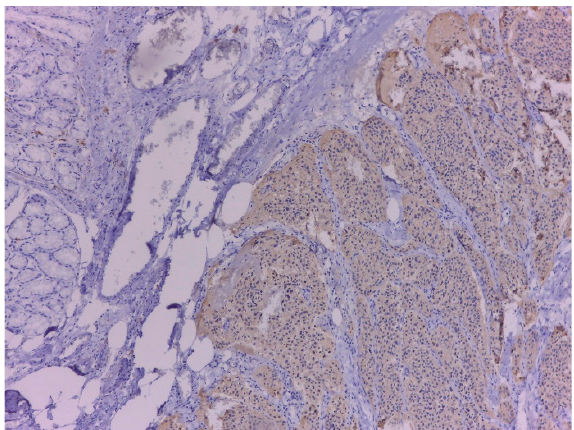
Figure 6. Well differentiated NEN located in the duodenal wall in Hematoxylin and eosin stain, ×100.